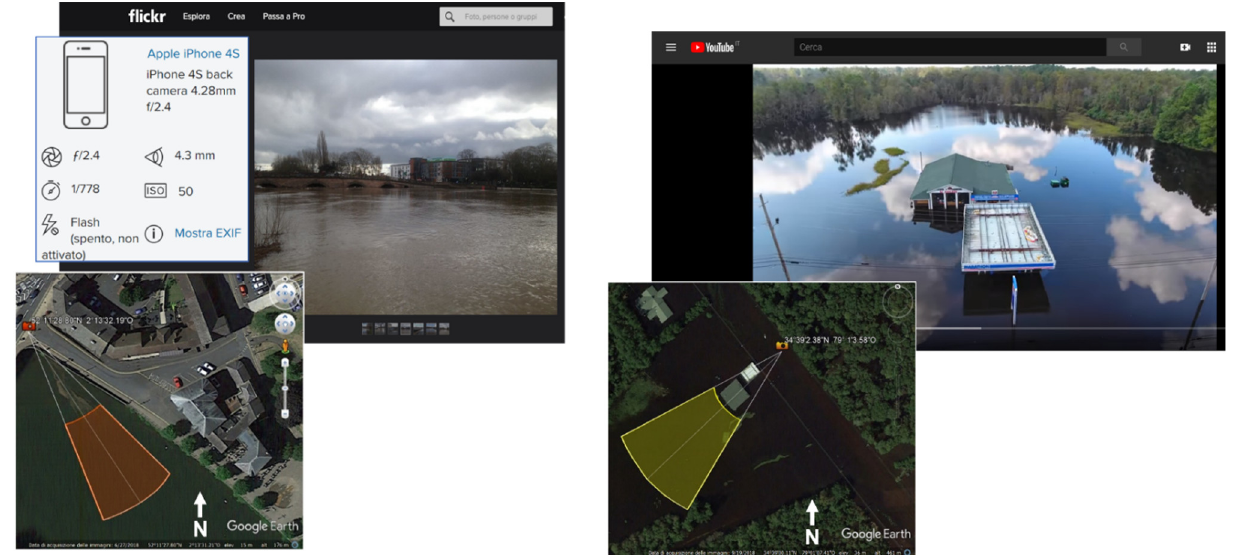
Figure 7. Examples of posts retrieved from Flickr and YouTube and used to construct the training samples. For the Flickr post, the metadata of the device used to take the picture is also shown.